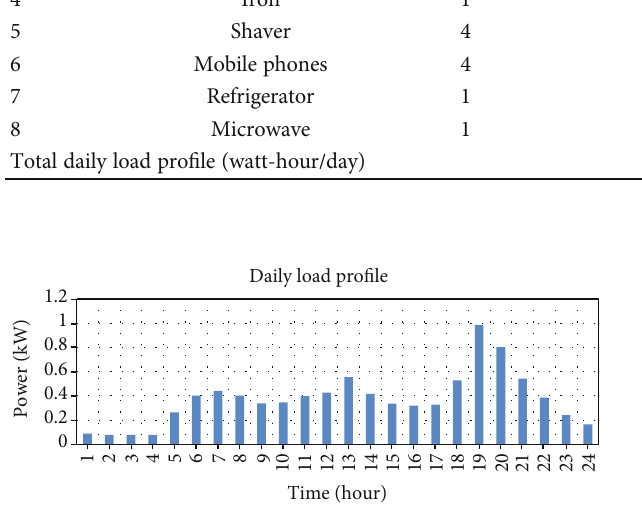
Figure 2: Daily electric load distribution for a residential home in Kigali